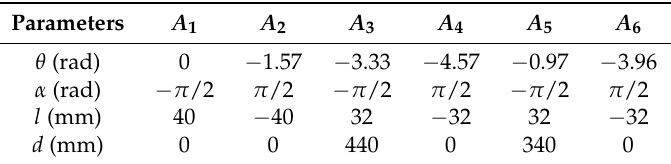
Table 1. Nominal values of structural